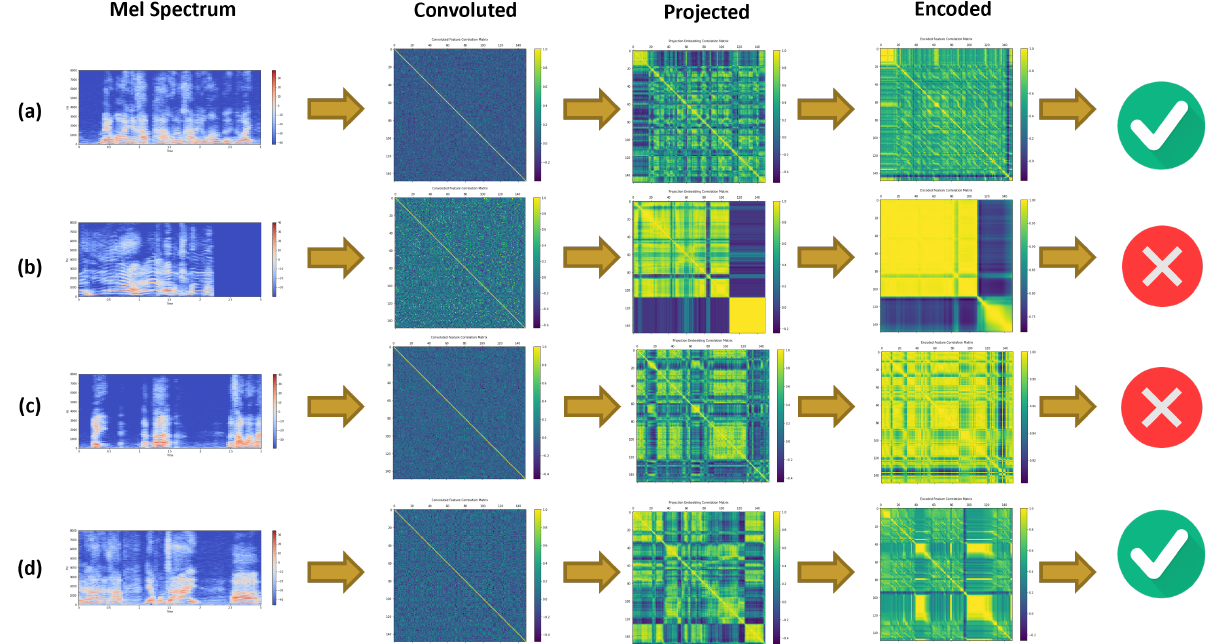
Figure 9. Correlation coefficients of E2ESER-CD using transfer learning of Wav2Vec2 with the CTR back-end network based on the ThaiSER dataset: ( a ) normal speech chunk, ( b ) chunk containing normal silence, ( c ) chunk containing mostly silence, and ( d ) chunk between speech. Note that the correct (green circle) and incorrect (red circle) signs are model results when compared with emotion labels. Please see the full resolution image in the supplementary